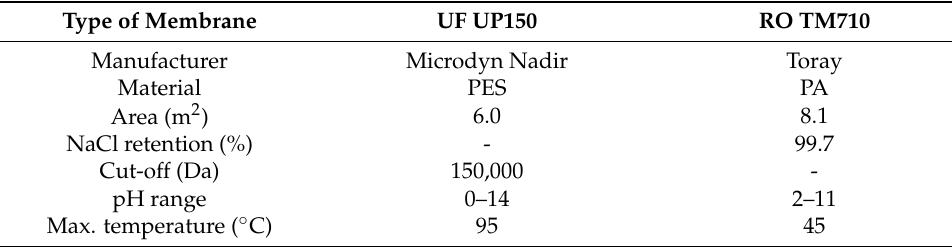
Table 1. Parameters of membranes used to treat galvanic wastewater.